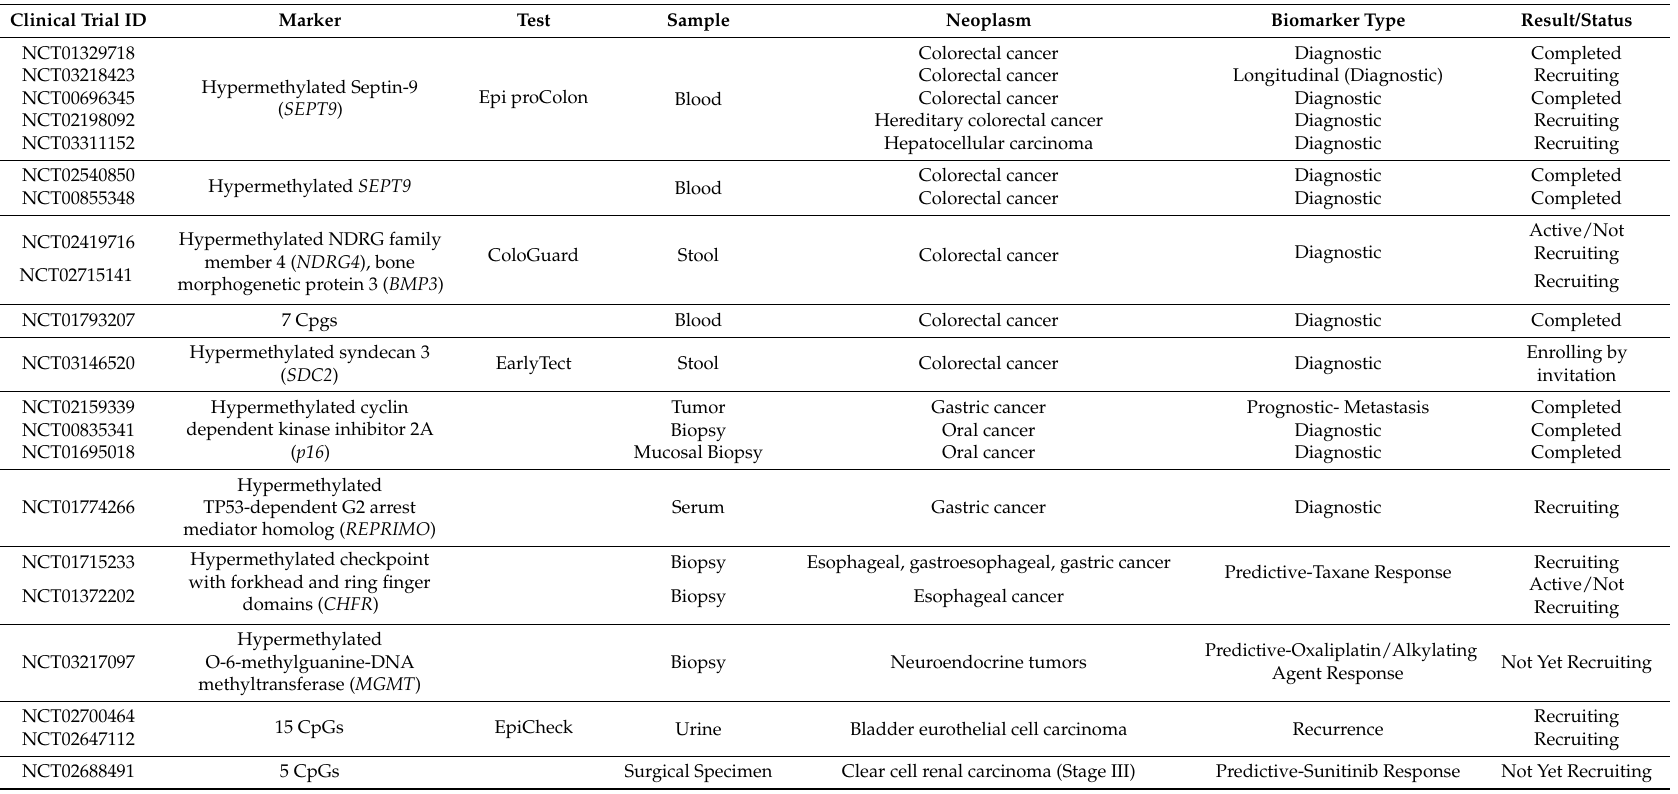
Table 1. Clinical trials using diagnostic, prognostic, or predictive biomarkers based on DNA